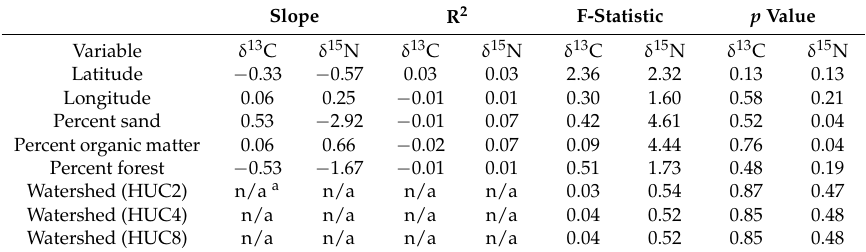
Table 2. Summary statistics of linear regressions of stable isotope content ( tcperthousand ) on environmental variables potentially relevant to 13 C and 15 N variation in plants. Degrees of freedom = 48. Slope R 2